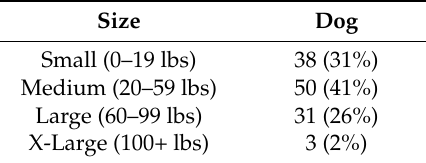
Table 3. Summary of size of the dogs in the sample.